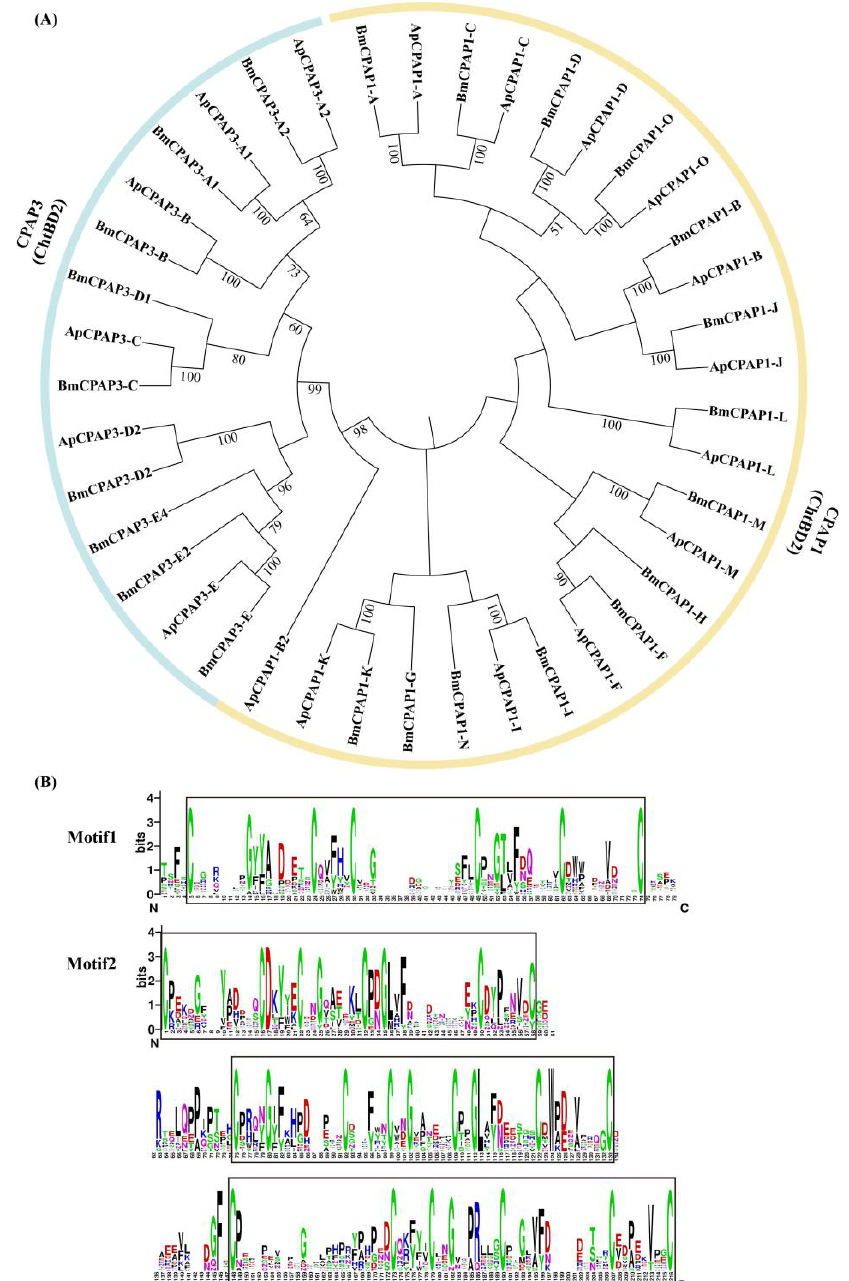
Figure 4. Phylogenetic relationship ( A ) and domain organization ( B ) of CPAP1 and CPAP3 proteins in A. pernyi (Ap) and B. mori (Bmor). The pink clades represent the ChtBD2s for CPAP1 proteins; the purple clades represent the ChtBD2s for CPAP3 proteins. The sequence logo shows the conserved region of the CPAP proteins in A. pernyi . The protein with one Cx 14–16 Cx 5 Cx 9–13 Cx 12 Cx 7–8 C motif is CPAP1 and the one with three Cx 13–24 Cx 5 Cx 9–10 Cx 12–16 Cx 7–8 C motifs is CPAP3. The chitin-binding domains (ChtBD2) are represented by squares. The sequence logos were generated by Weblogo